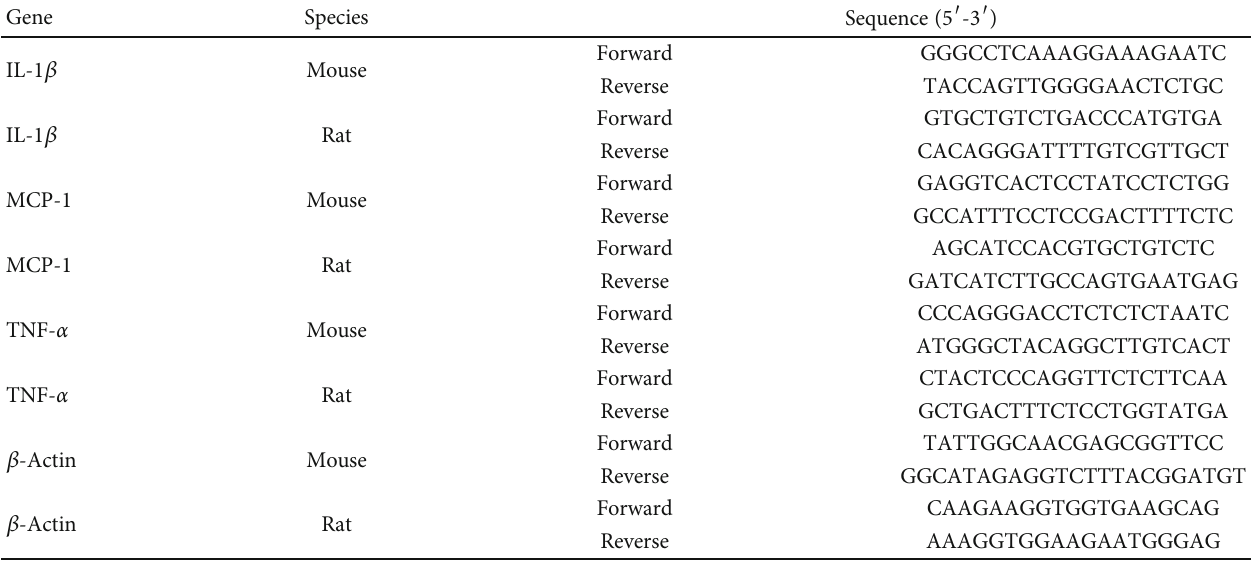
Table 1: Primer sequences for RT-PCR